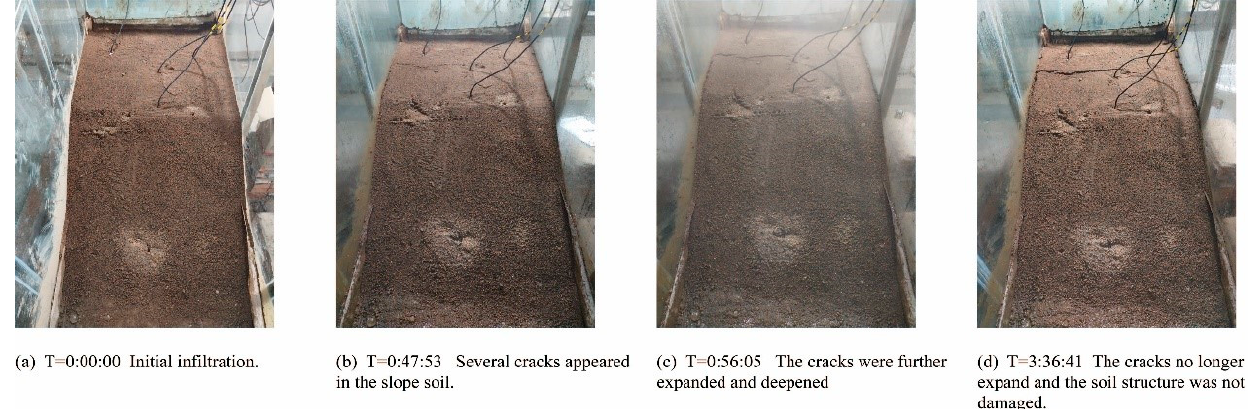
Figure 15. Damage characteristics of ZJCG condition under extraordinary rainstorm (77.65 mm/h).